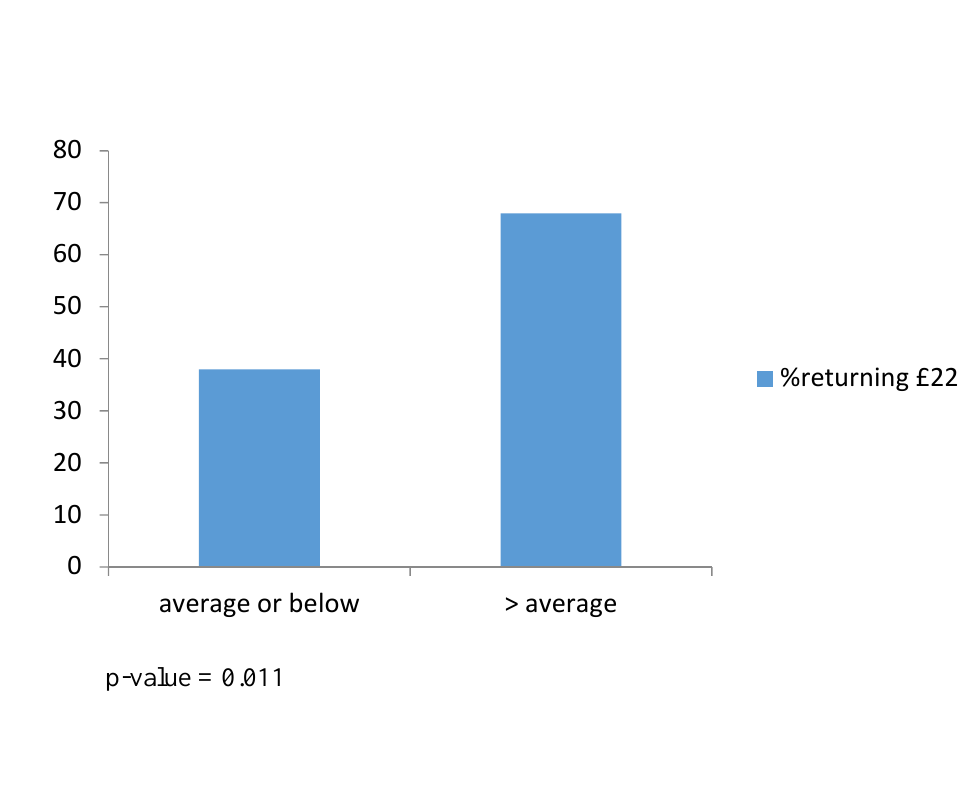
Figure 4: Long-term relative income in 2007 and